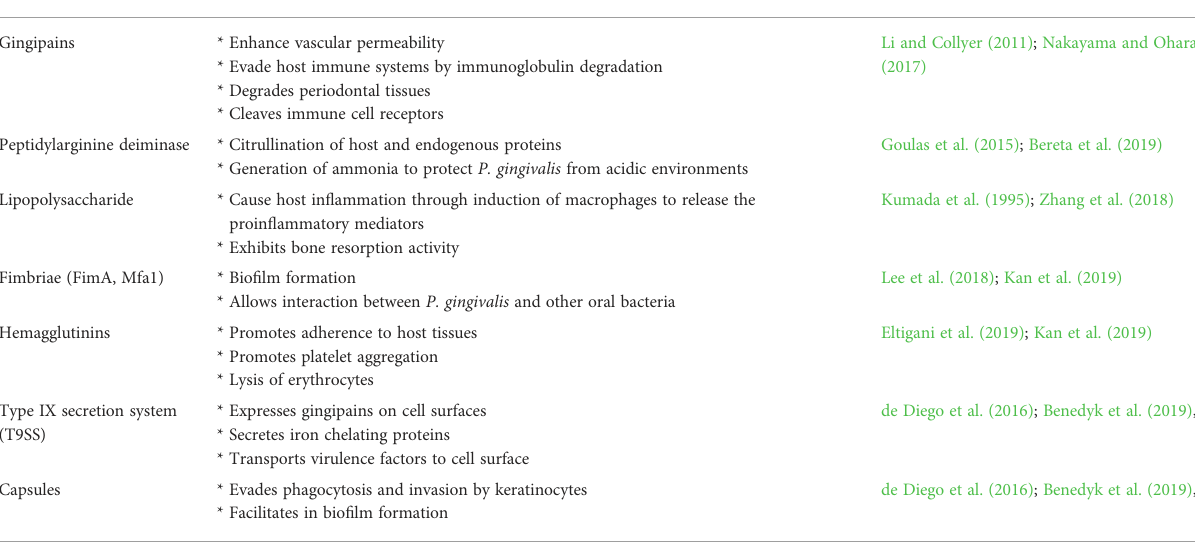
TABLE 1 Virulence factors present in P. gingivalis